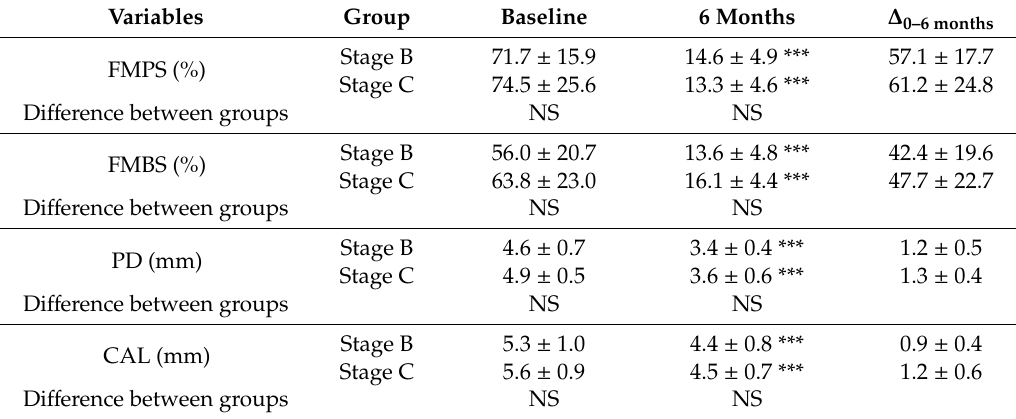
Table 1. Changes in clinical variables (mean ± SD) over the 6-month experimental period (full-mouth data).